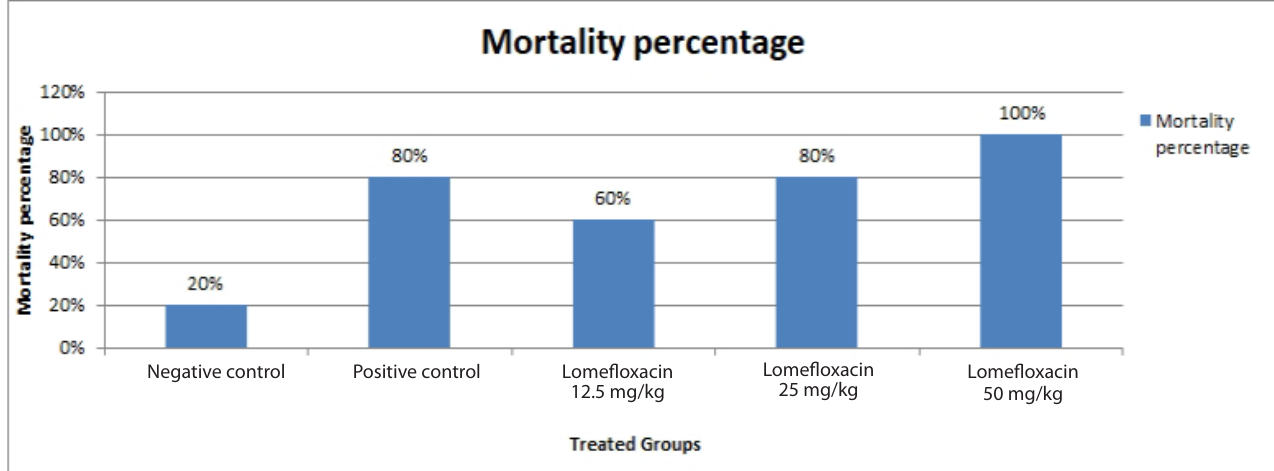
FIGURE 5 - Comparison of percentage mortality in control group and lomefloxacin treated